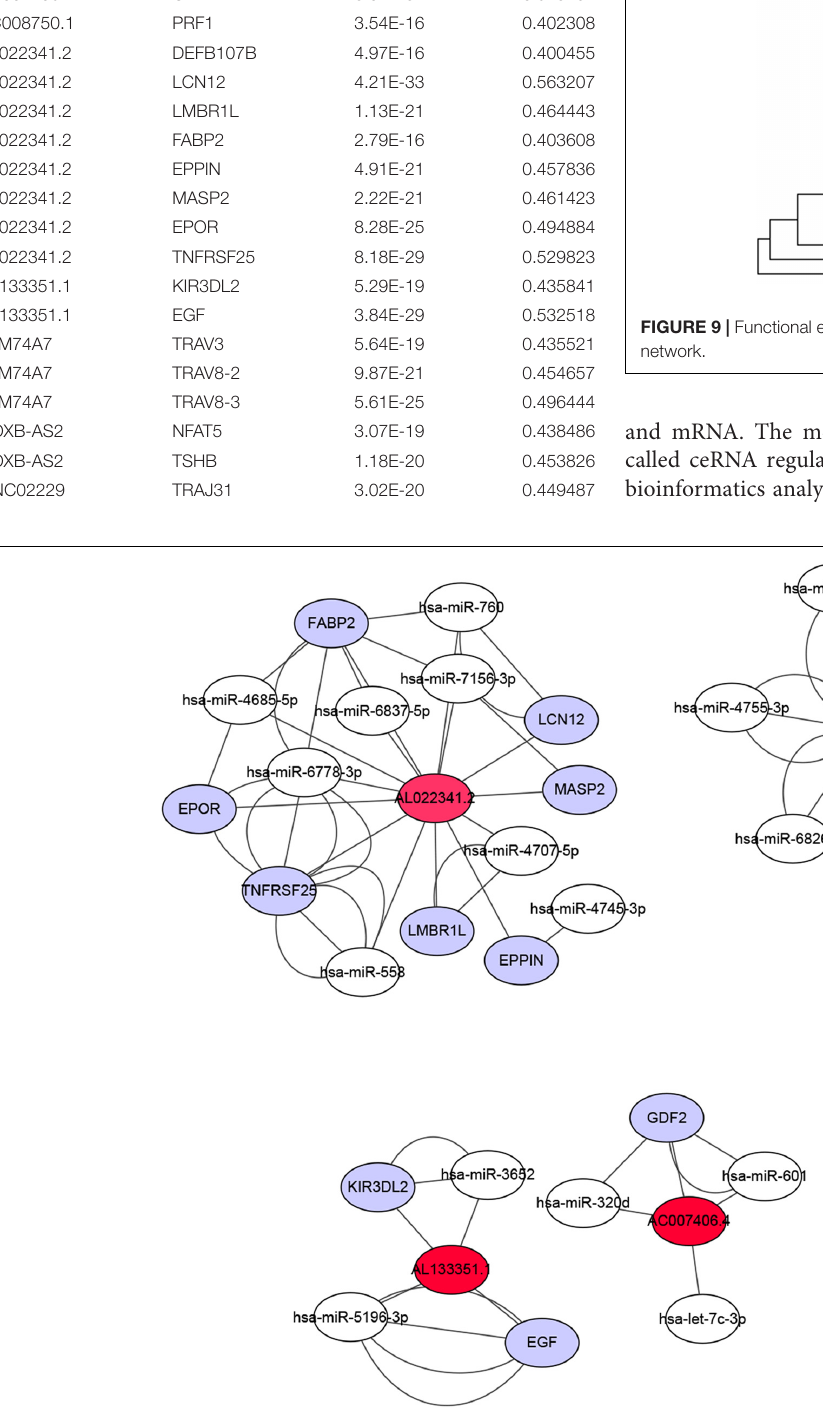
Frontiers in Genetics |